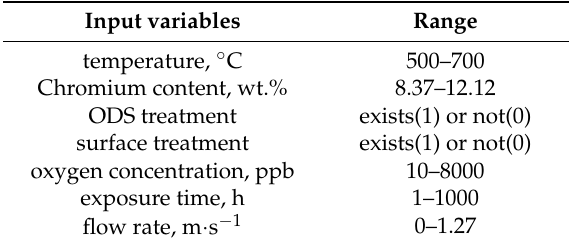
Table 1. Input parameters employed in the neural network